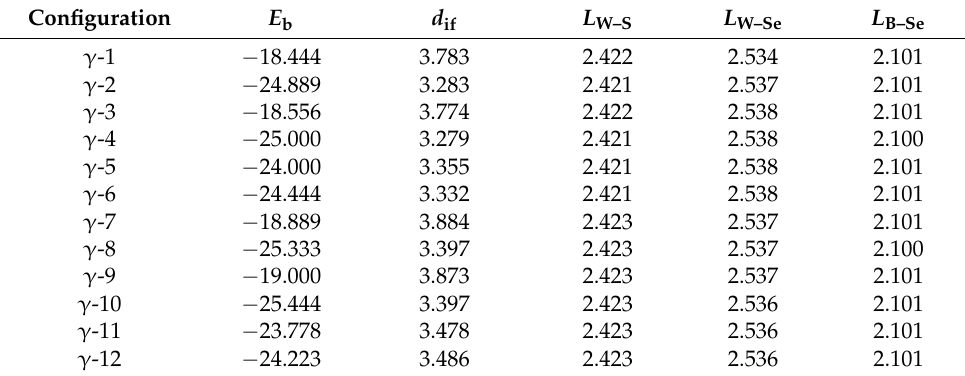
Table 1. The binding energy ( E b , meV/Å − 2 ), interface distance ( d if , Å), and bond length ( L , Å) of W–S, W–Se and B–Se in WSSe and BSe, respectively. Configuration E